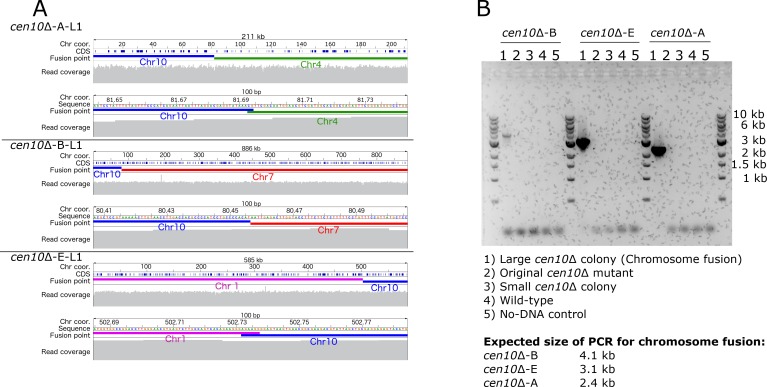
Chromosome fusion in large cen10∆ colonies.Sequence reads were mapped back to the de novo cen10∆ genome assemblies to verify the quality of the de novo cen10∆ mutant genome assemblies. For each panel the full length of the scaffold, which includes the fusion point, and a 100 bp detailed region is shown. Sequences homologous to chromosome 10 are depicted in blue and sequence reads mapped back to the de novo genome assemblies are shown in grey. (A) The de novo genome assembly of cen10∆-A-L1 contains a scaffold (~211 kb) of a fused chromosome and this scaffold consists of an 81.97 kb region of chromosome 10 (blue) and a 129.38 kb region of chromosome 4 (green). The sequence coverage of this scaffold is 104 fold. The chromosome fusion occurred with a 2 bp overlap between chromosome 4 and 10. (B) The de novo genome assembly of cen10∆-B-L1 contains a scaffold (~886 kb) and consists of an 80.46 kb region of chromosome 10 (blue) and an 806.09 kb region of chromosome 7 (red). The fusion point lacks overlap between chromosomes 7 and 10. The sequence coverage of this scaffold is 104 fold. (C) The de novo genome assembly of cen10∆-E-L1 consists of a scaffold (~585 kb) of a fused chromosome and this scaffold consists of an 83.59 kb region of chromosome 10 (blue) and 501.37 kb of chromosome 1 (pink). The sequence coverage of this scaffold is 140 fold. The chromosome fusion occurred with a 6 bp overlap between chromosome 1 and 10. (D) PCR confirmation of the chromosome fusion occurring in the large colonies derived from cen10∆-B, cen10∆-C, and cen10∆-A. For each chromosomal fusion, a PCR spanning the fusion was performed. For each chromosome fusion, PCRs were performed for: 1) a large colony derived from the cen10∆ mutant, 2) the original cen10∆ mutant, 3) a small colony derived from growth at 37°C, and 4) the wild type.